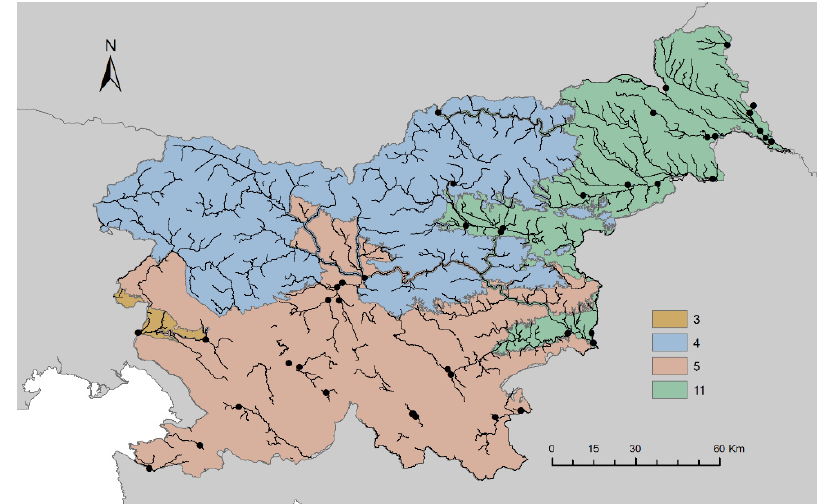
Figure 1. Location of the sampling sites (Ecoregions: 3—Po lowland, 4—Alps, 5—Dinaric Western Balkan, and 11—Pannonian lowland).